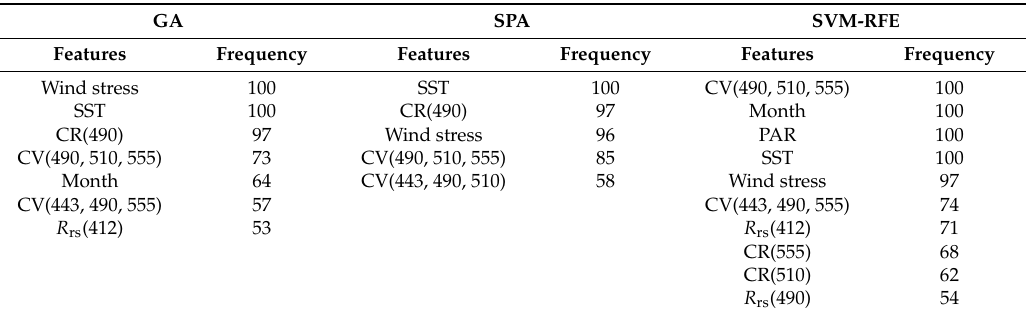
Table 7. Sensitive features for retrieving picoplankton size fractions selected, respectively, by genetic algorithm (GA), successive projection algorithm (SPM), and recursive feature elimination based on support vector machine regression (SVM-RFE).